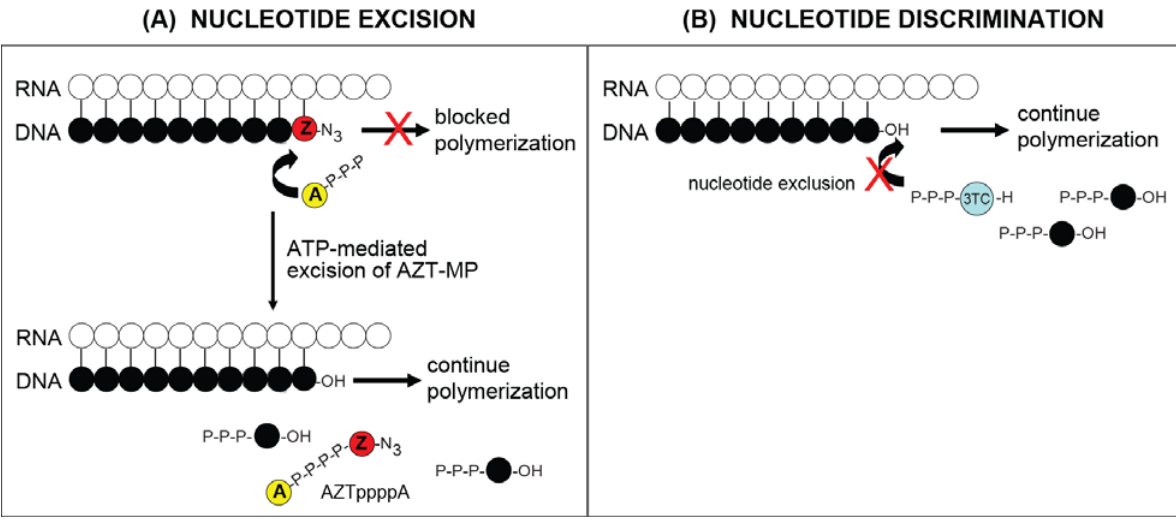
(AZT-MP) yielding an AZTppppA excision byproduct. (B) Nucleotide discrimination. Mutations in pol cause steric hindrance at the pol active site, excluding certain drugs, for example 3TC, from being incorporated during reverse transcription. Both examples yield a complex competent for polymerization. Yellow circle with the letter A and three phosphates, ATP; black circles with three phosphates, dNTPs; red circle with the letter Z and the N3 azido group, AZT-MP; blue circle with three phosphates, 3TC-triphosphate; P, phosphate group. RNA is depicted with white circles; DNA is depicted with black